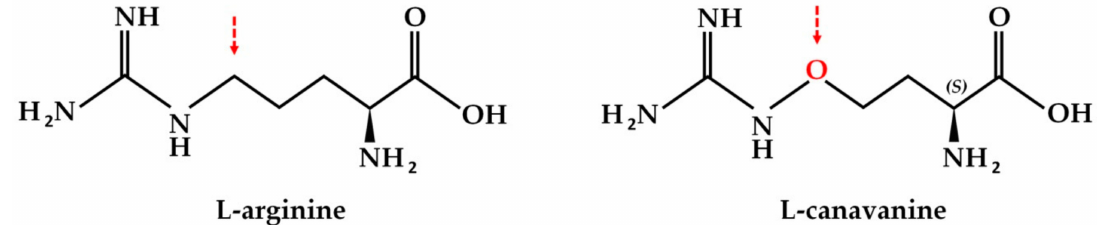
Figure 1. Chemical structures of l -arginine and l